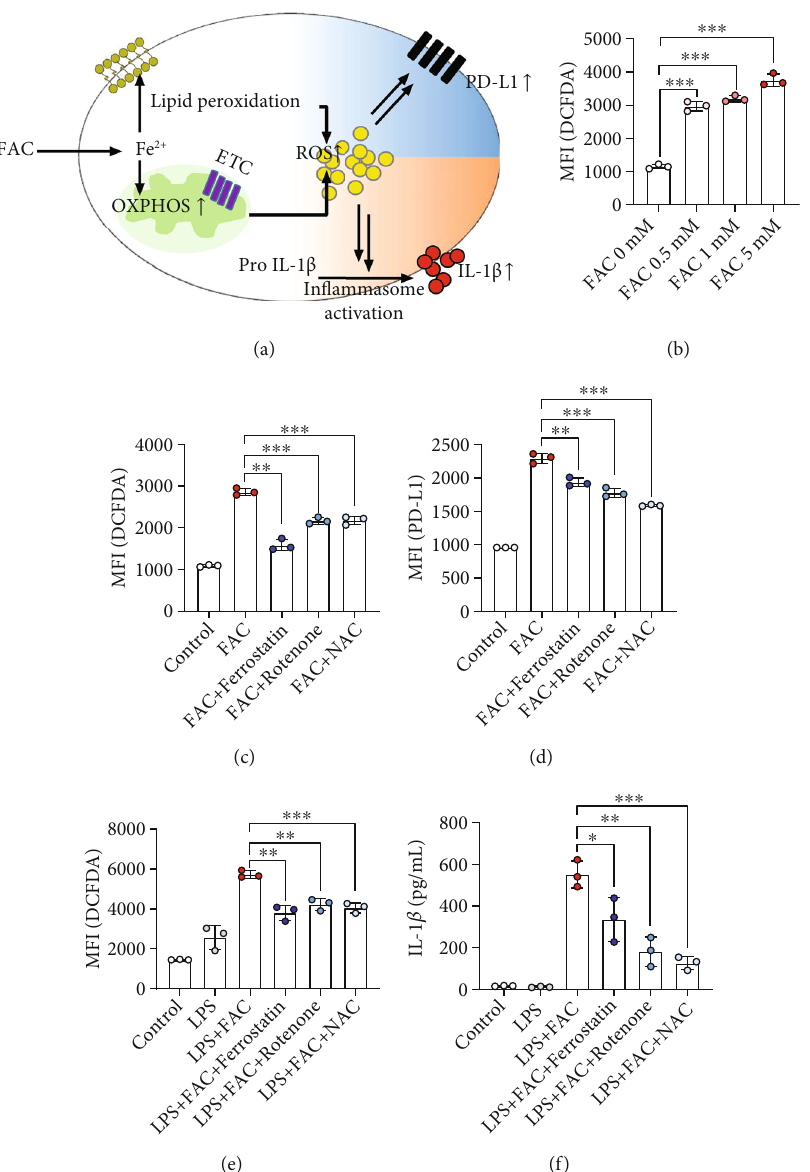
Figure 4: Role of ROS in FAC-mediated IL-1 β and PD-L1 production. (a) Schematic diagram explaining FAC-mediated in fl ammatory response in macrophages. (b) BMDMs were incubated with FAC at concentrations of 0.5, 1, and 5 mM for 16h. ROS production in F4/ 80 + macrophages was measured by fl ow cytometry. (c, d) BMDMs were incubated with FAC at a concentration of 0.5mM FAC in the presence of 2 μ M ferrostatin, 0.1mM rotenone, and 0.2 μ M NAC for 16 h. ROS (c) and PD-L1 production (d) in F4/80 + macrophages were measured by fl ow cytometry. (e, f) BMDMs were pretreated with LPS 500ng/mL for 3h. After priming, 0.5mM FAC, 2 μ M ferrostatin, 0.1mM rotenone, and 0.2 μ M NAC were coincubated with 1 mM ATP for 4 h. ROS (e) and IL-1 β production (f) were